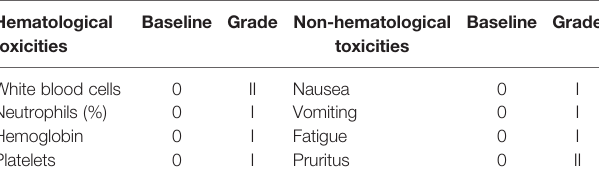
TABLE 1 | Hematological and non-hematological toxicities during neoadjuvant therapy (grading according to CTCAE 3.0). Hematological